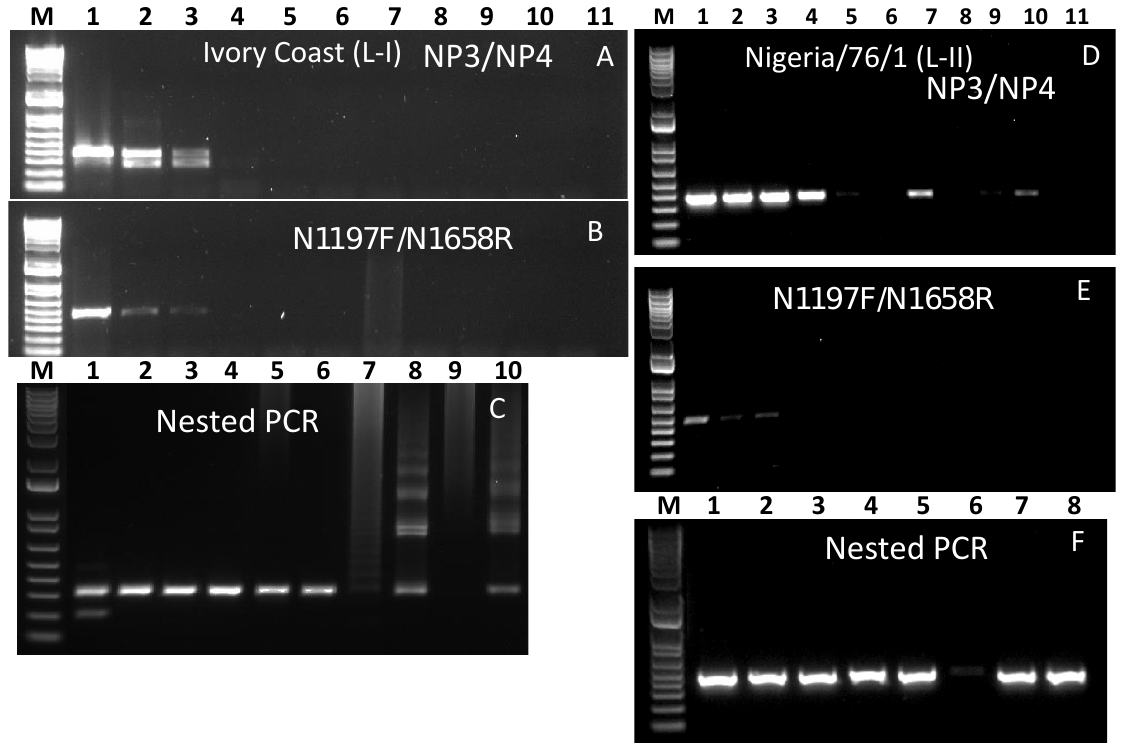
Figure 2. Gel images of PCR products using RNA of lineage I virus Ivory Coast ( A – C ) and lineage II virus Nigeria/76/1 ( D – F ). ( A , D ): PCR products obtained from first round of PCR using primer pair NP3/NP4, ( B , E ): PCR products obtained from first round of PCR using primer pair N1197F/N1658R, ( C , F ): PCR products obtained from nested PCR using primer pair NP3/NP4. M: 1 kb plus marker DNA; lanes 1–11 in A , B , D , E correspond to neat, 10 −1 to 10 −10 RNA, respectively. Lanes 1–10 in C correspond to 10 −1 to 10 −10 RNA, and lanes 1–8 in F correspond to 10 −1 to 10 −8 RNA, respectively.